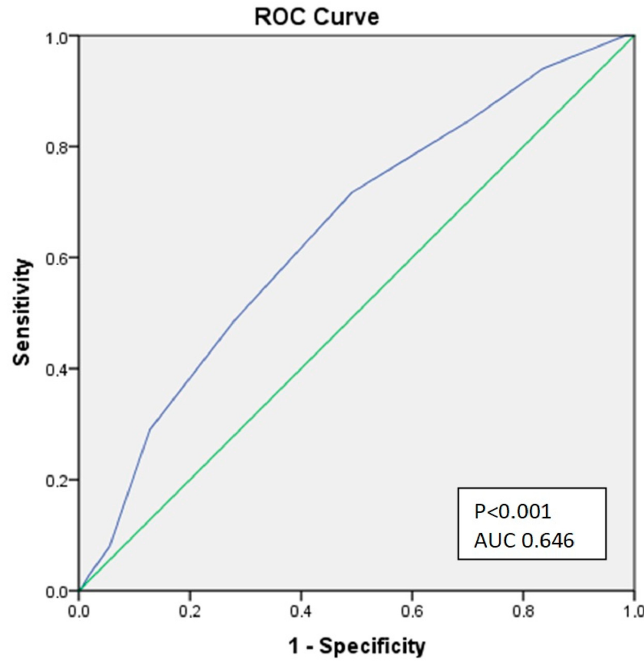
Figure 1. Figure 1. AUROC CHA2DS2-VASc one-year